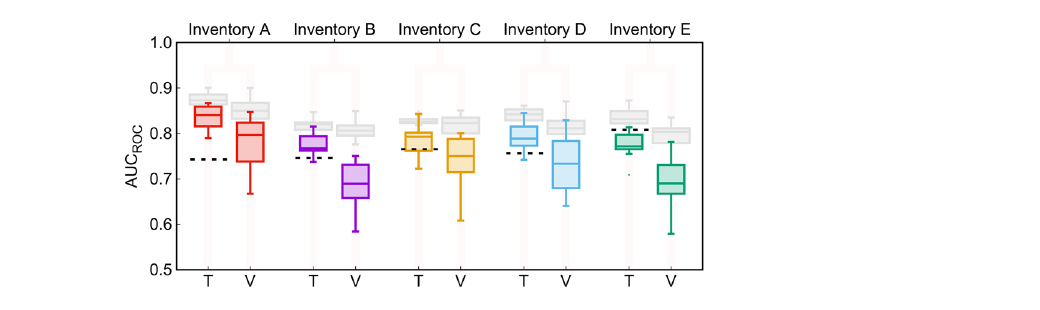
Figure 8. Boxplots showing AUC ROC values for the five inventories in the overlap region considered in this work ( cf. Figure 1). Boxplots in color correspond to training/validation strategy TR1; grey to TR2; dotted lines to TR3; see Sect. 3 for a description of the different